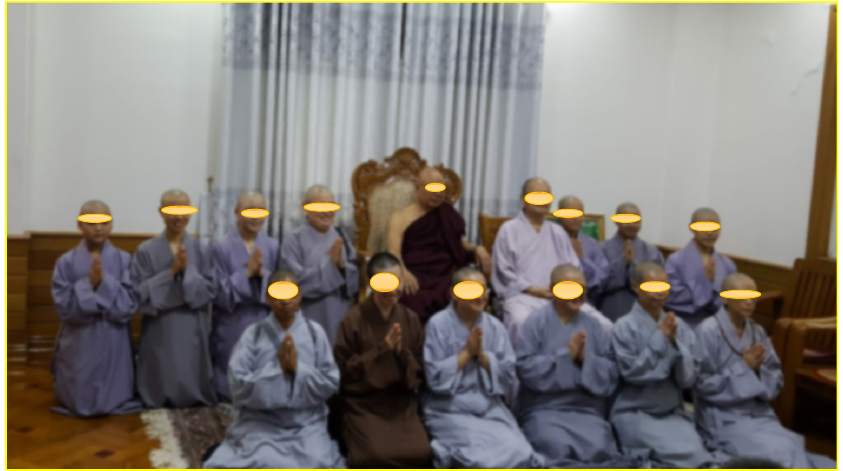
Figure 3. Monks seated at higher levels than Sino-Burmese nuns while posing for photos (Source: Author).